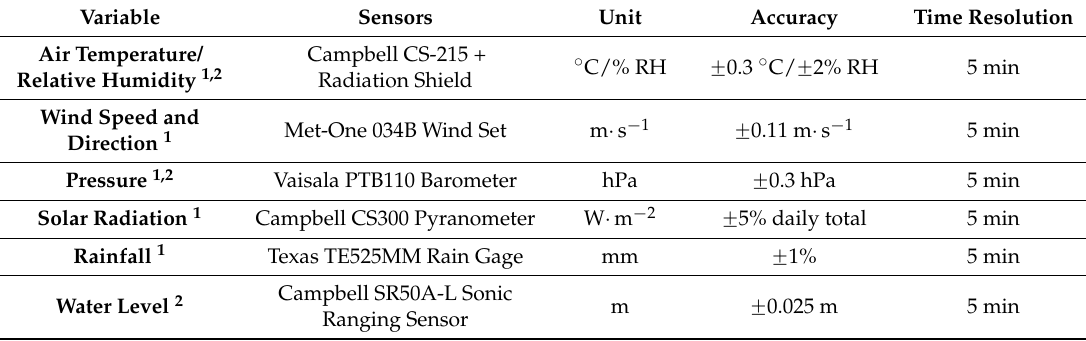
Table 2. List of sensors used in the study.